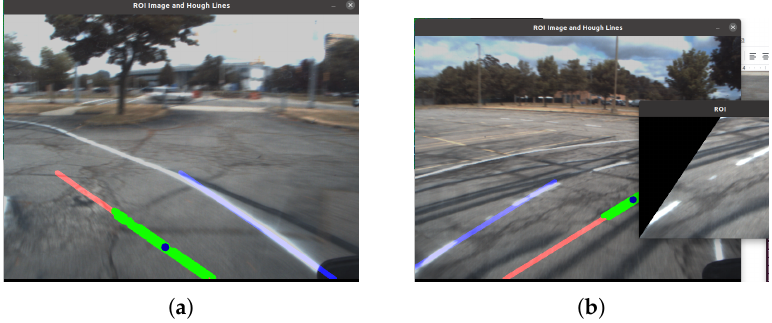
Figure 14. Hough Lines and Contour Detection. This is an image from the implementation of the algorithm in the real-time environment. The above figure shows the Hough Lines for the white lines drawn in blue and the center lane line drawn in red. Red was chosen as the color for the center line as red is not typically found on roads. The green on the red line indicates the Contour Detection of the center line. ( a ) Outer lane; ( b ) Inner lane.